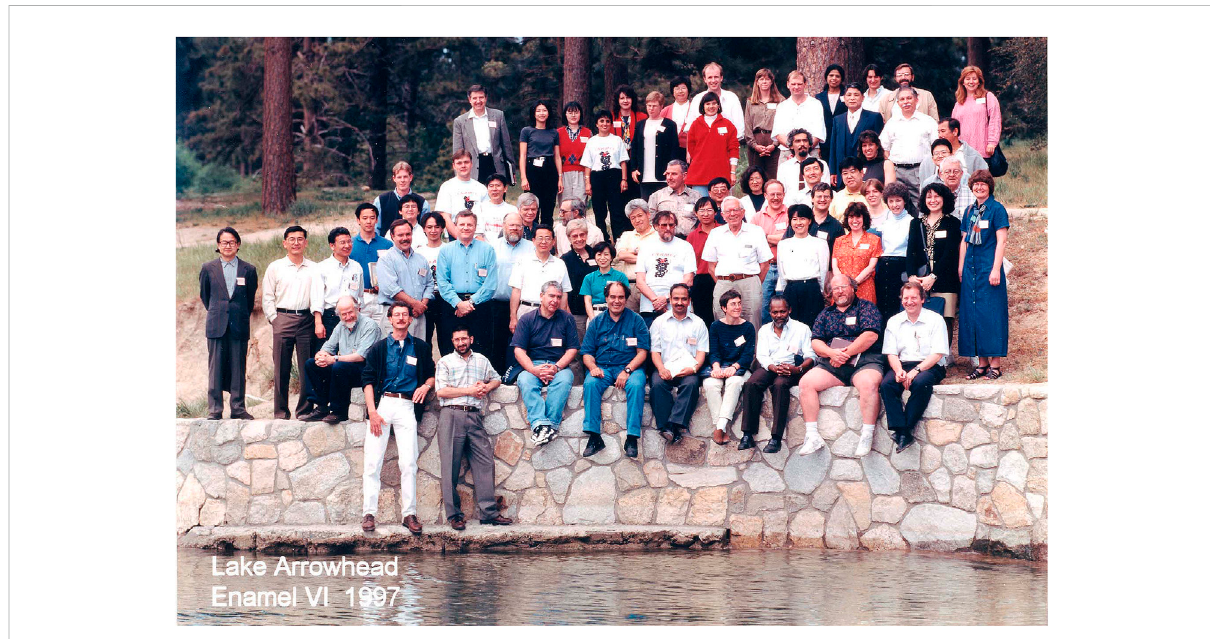
FIGURE 3 Enamel VI, group picture. Alan is in the second row from the bottom wearing an “ Enamel ” T-shirt. Photograph taken by the author in 1997.